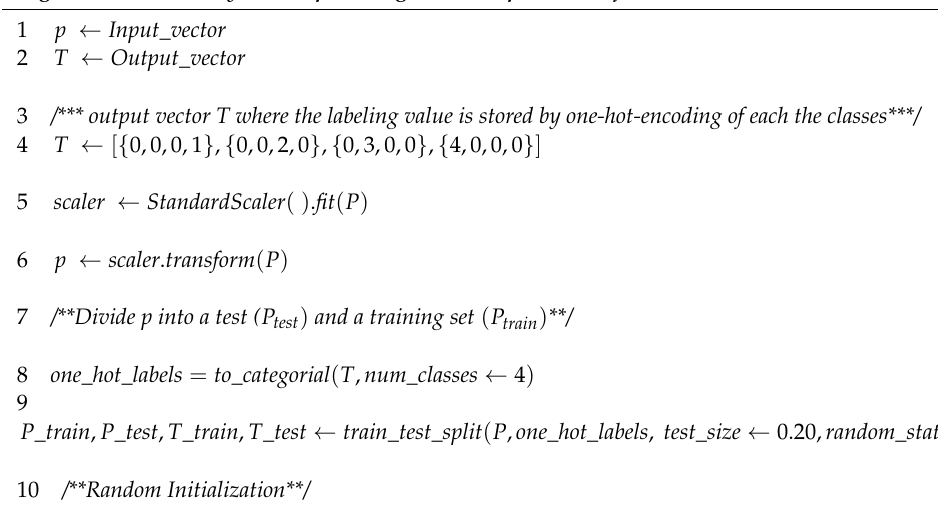
Algorithm 1: Multilayer Perceptr ó n algorithm implemented for the